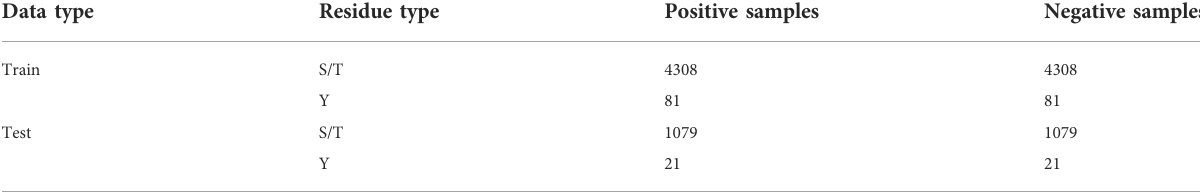
TABLE 1 Phosphorylation data collected in this